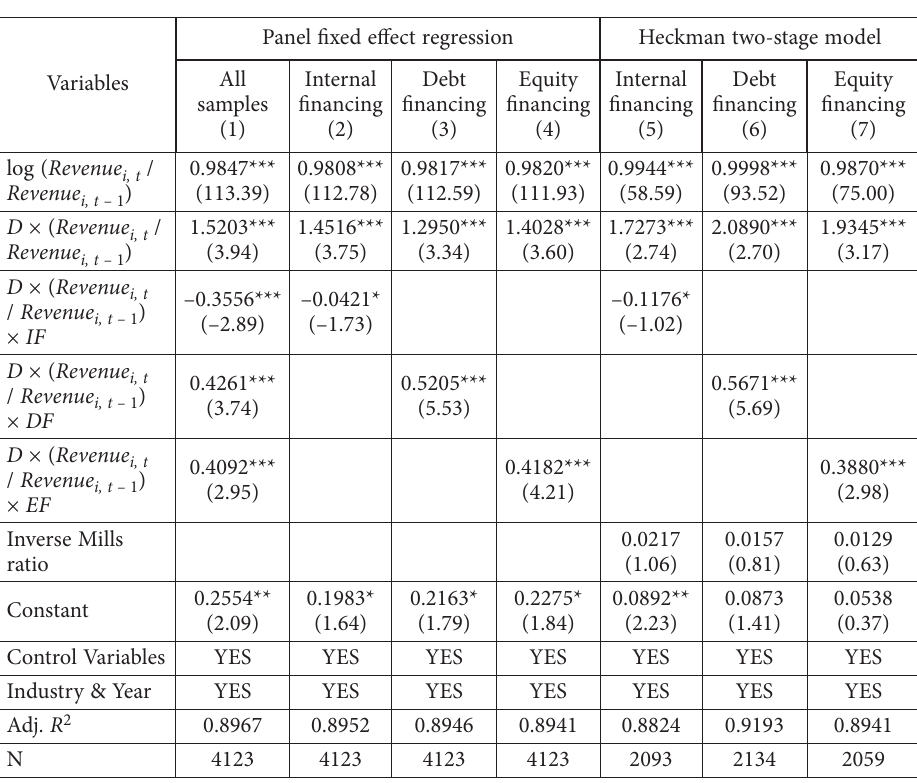
Table 8. Discussion of endogenous